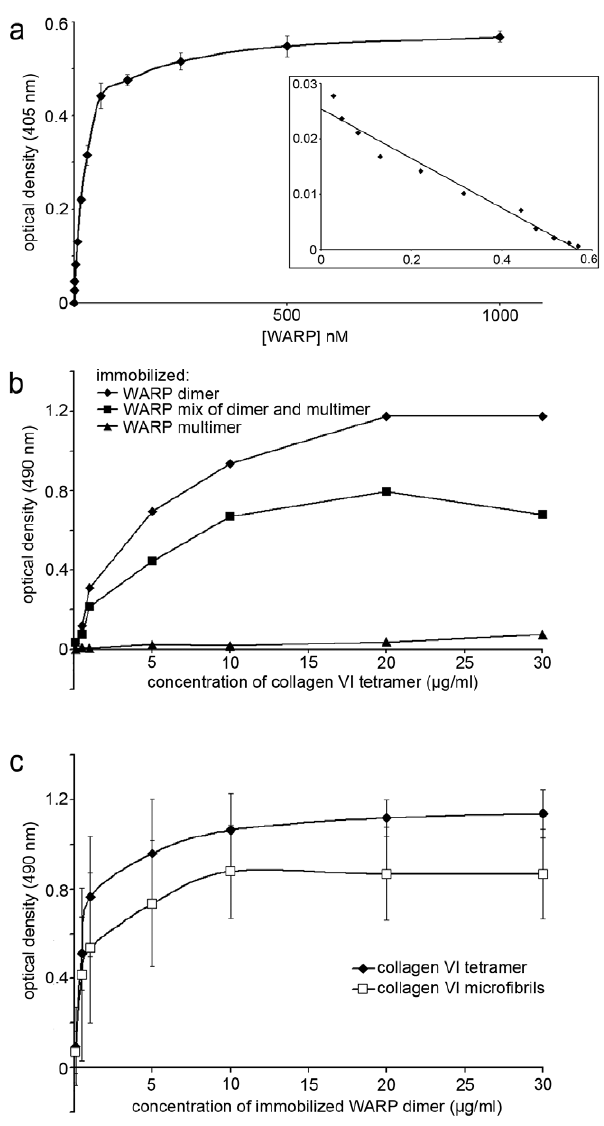
Figure 5. Solid phase analysis of WARP/collagen VI interaction. a, WARP binding to collagen VI tetramers. Coated collagen VI was incubated with recombinant WARP. Data are means of triplicate determinations + / 2 SE. Inset , Scatchard analysis of binding data reveals an apparent kDa of 22 nM. b, Reciprocal solid phase binding experiment showing collagen VI binding to coated WARP dimer but not WARP multimers. Representative curves are shown. c, WARP binds to both pepsinized collagen VI tetramers (black diamonds) and pepsinized intact collagen VI (white squares).